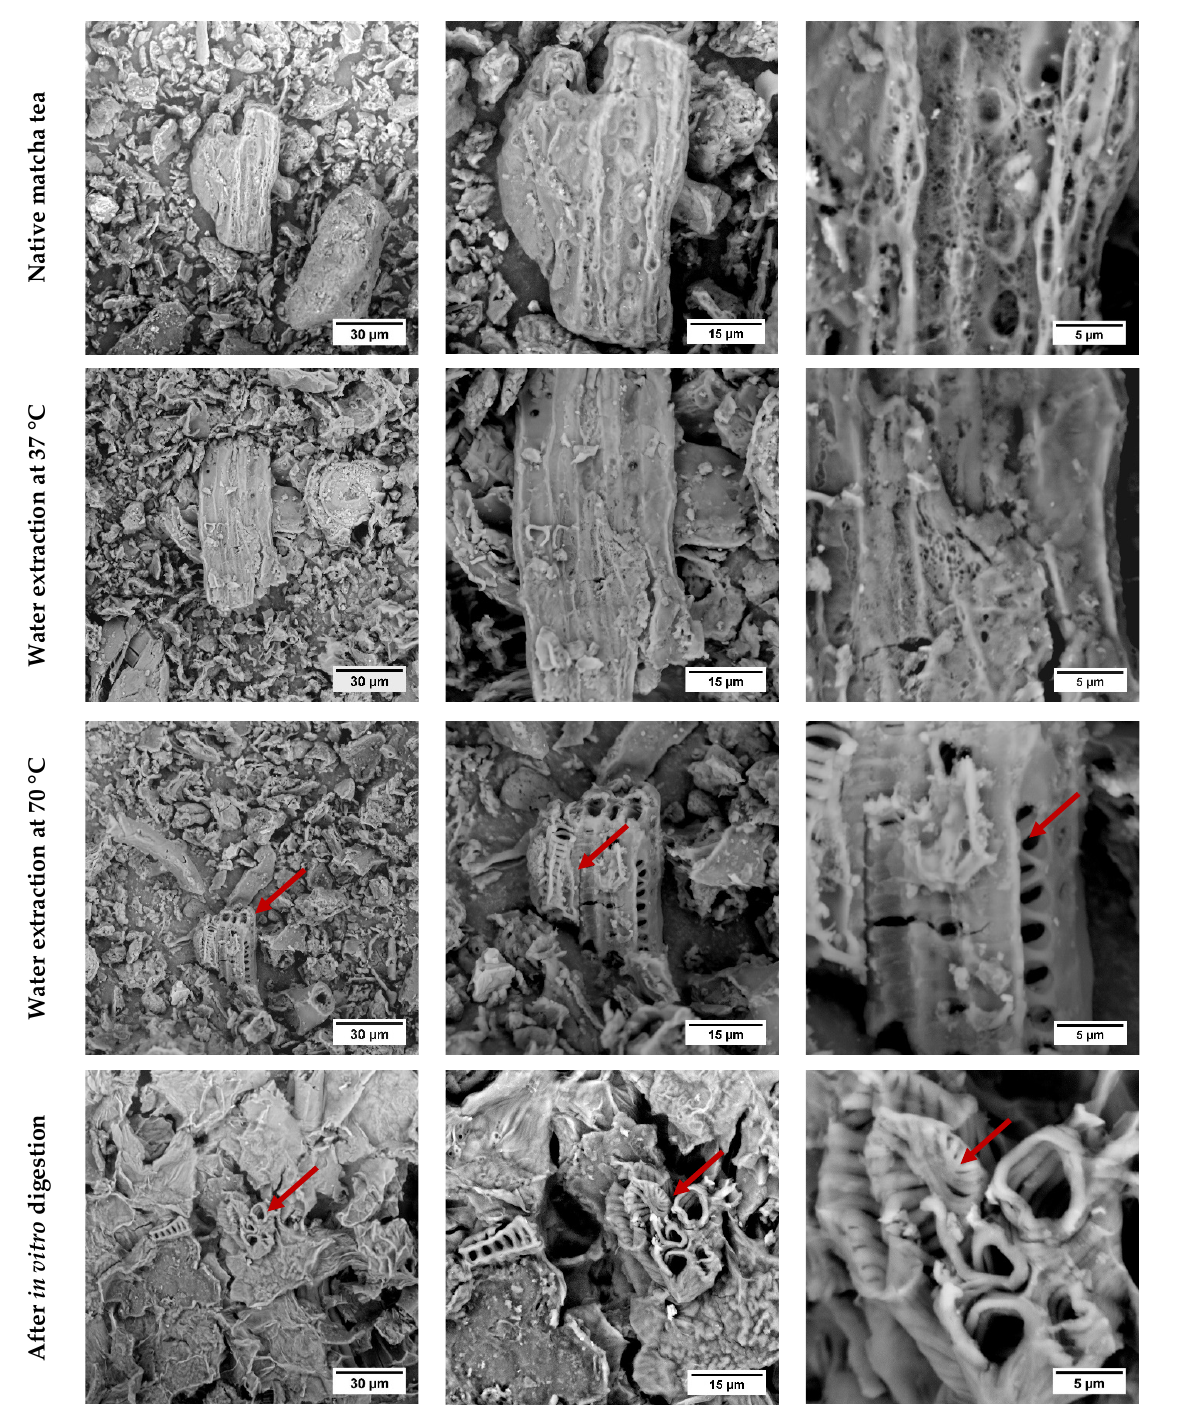
SEM images of the native matcha tea powder (the first row from the top), water ex- tract at 37 °C (the second row from the top), water extract at 70 °C (the third row from the top), and matcha tea after in vitro digestion (the fourth row from the top) obtained at the magnification levels of 1500× (the first column), 3500× (the second column), and 10,000× (the third column) are shown in Figure 2.